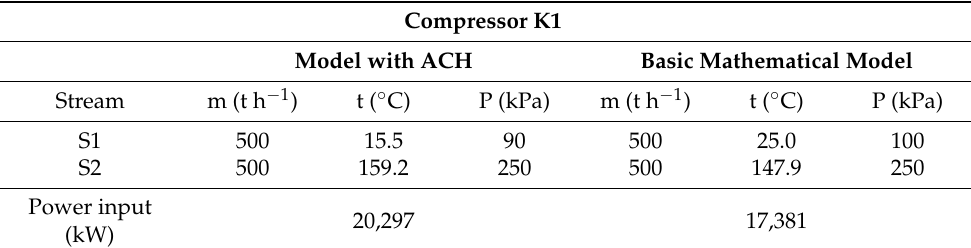
Table 11. Comparison of key parameters related to compressor K1 obtained by basic ASU model and by model comprising